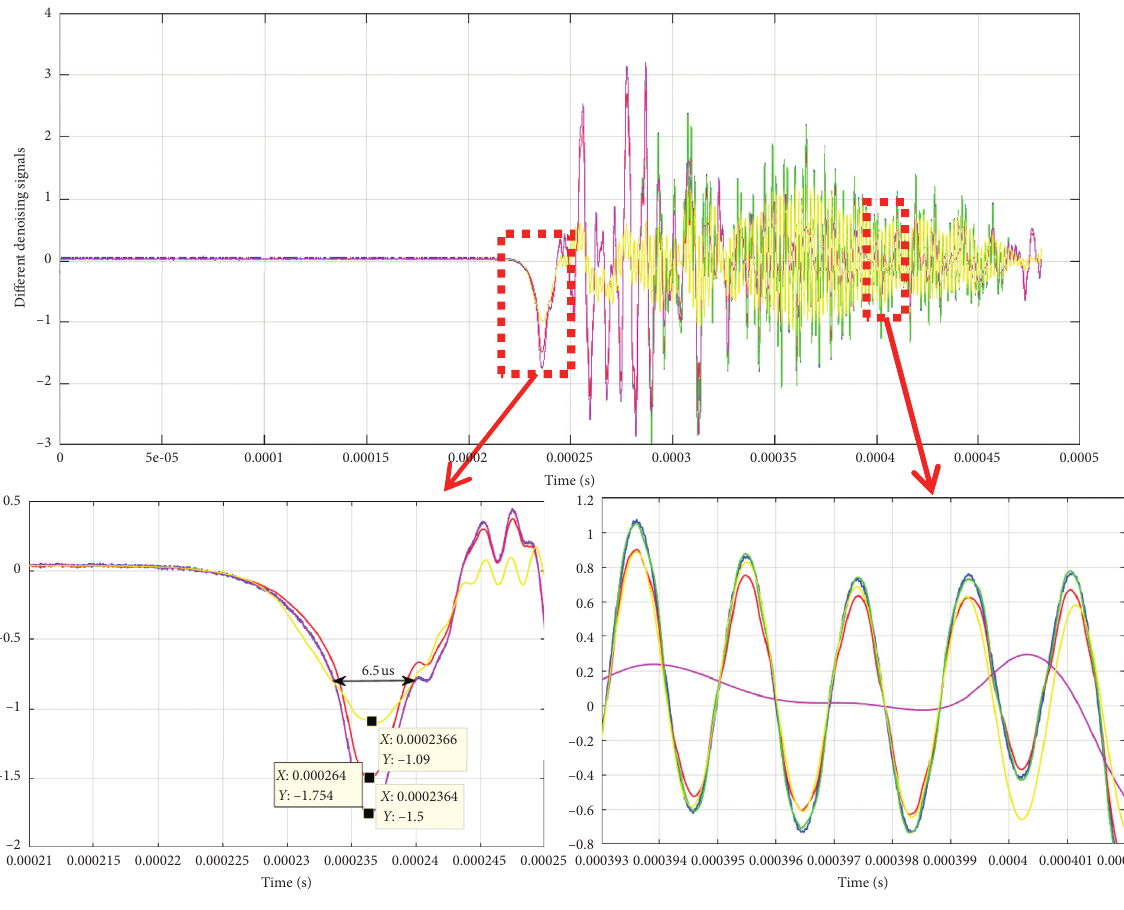
Figure 13: The denoising effect of different methods in dynamic